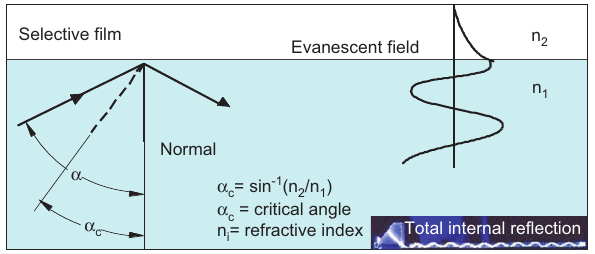
Figure 3 Principle of evanescent wave. Adapted with permission from “ Kaval, N.; Seliskar, C.J.; Heineman, W.R. Anal. Chem. 2003 , 75 , 6334 ” Copyright © 2003, American Chemical